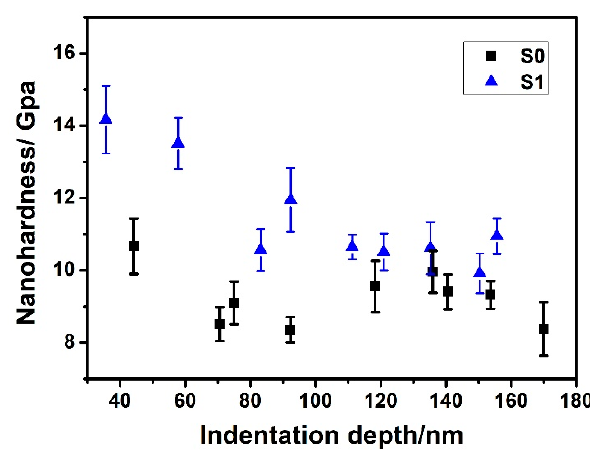
Figure 7. Nanohardness versus indentation depth for samples S0, S1.